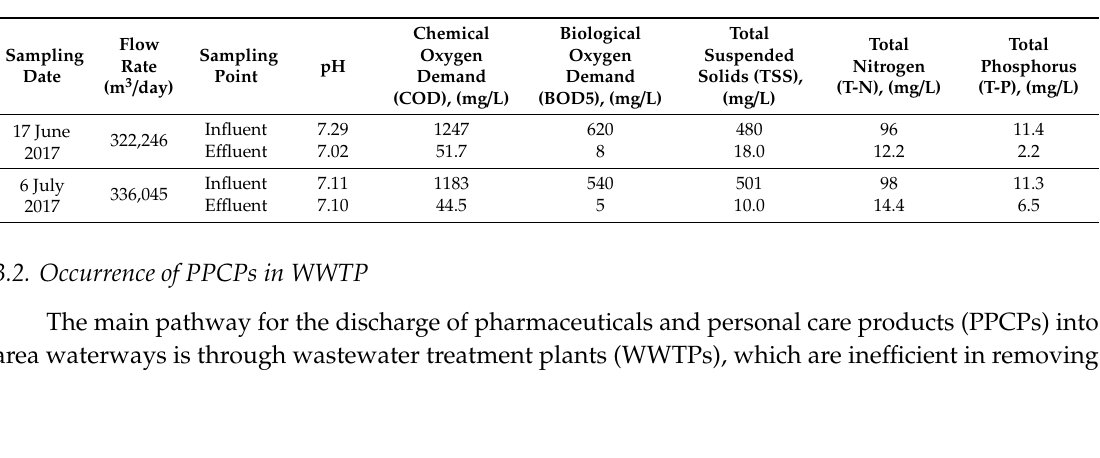
Table 2. Wastewater quality and operating conditions for the influent and e ffl uent in As-Samra WWTP during sample